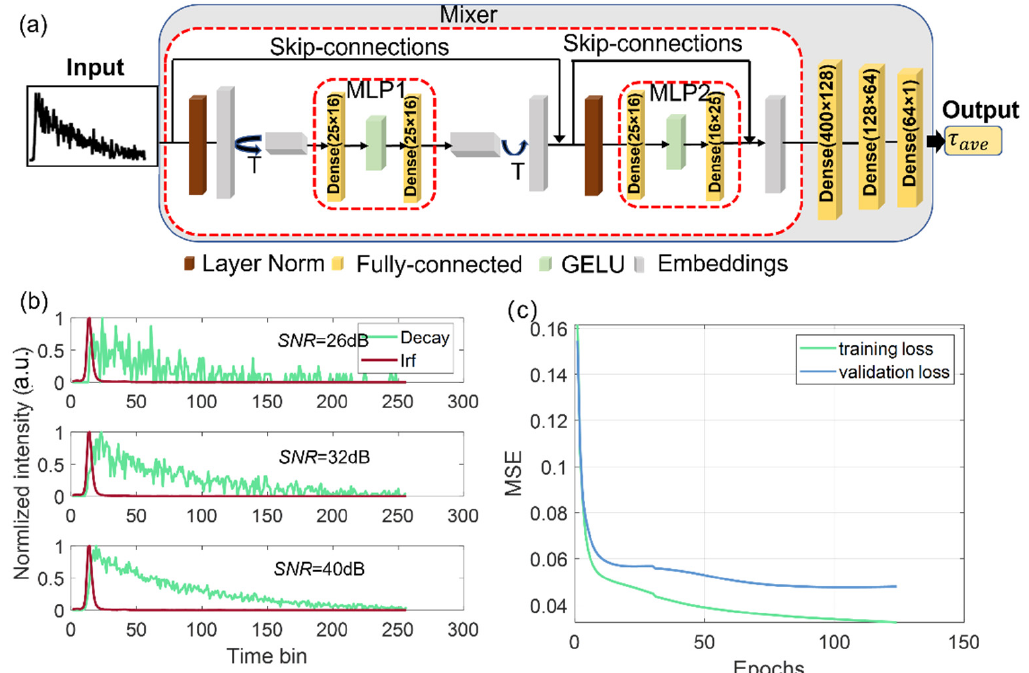
Figure 2. ( a ) MLP-Mixer architecture. The MLP-Mixer consists of per-patch linear embeddings, mixer layers, and a regression layer. The mixer block contains one token-mixing MLP (MLP1) and one channel-mixing MLP (MLP2), each consisting of two fully connected layers and a GELU non- linearity. Other components include skip connections, dropout, and layer norm on channels. ( b ) Decays under different SNRs, the green curve stands for decay, and the red curve means IRF. ( c ) Mean square error (MSE) plots of the training and validation loss for τ _ave.